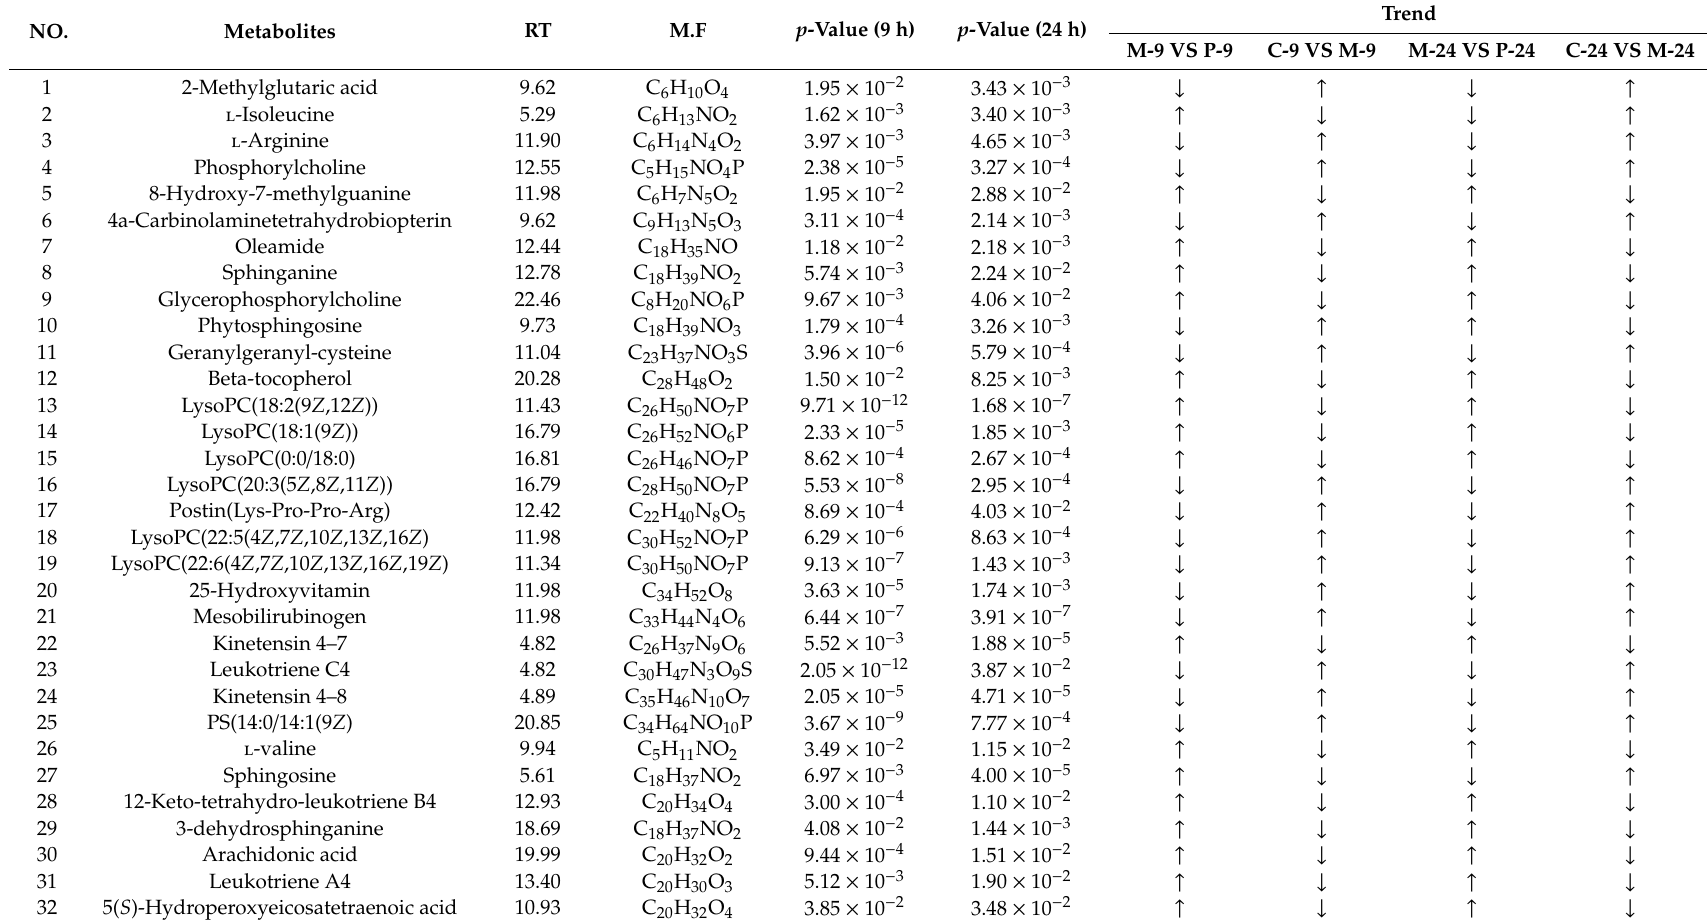
Table 2. Identification of potential biomarkers of rat serum samples among control groups, model groups and P-b4